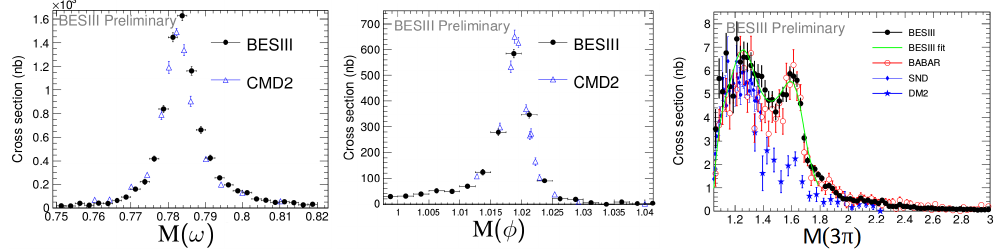
Figure 3. e + e − → π + π − π 0 cross section in the ω -resonance region (left), the φ -resonance region (middle) and in the region above the φ resonance